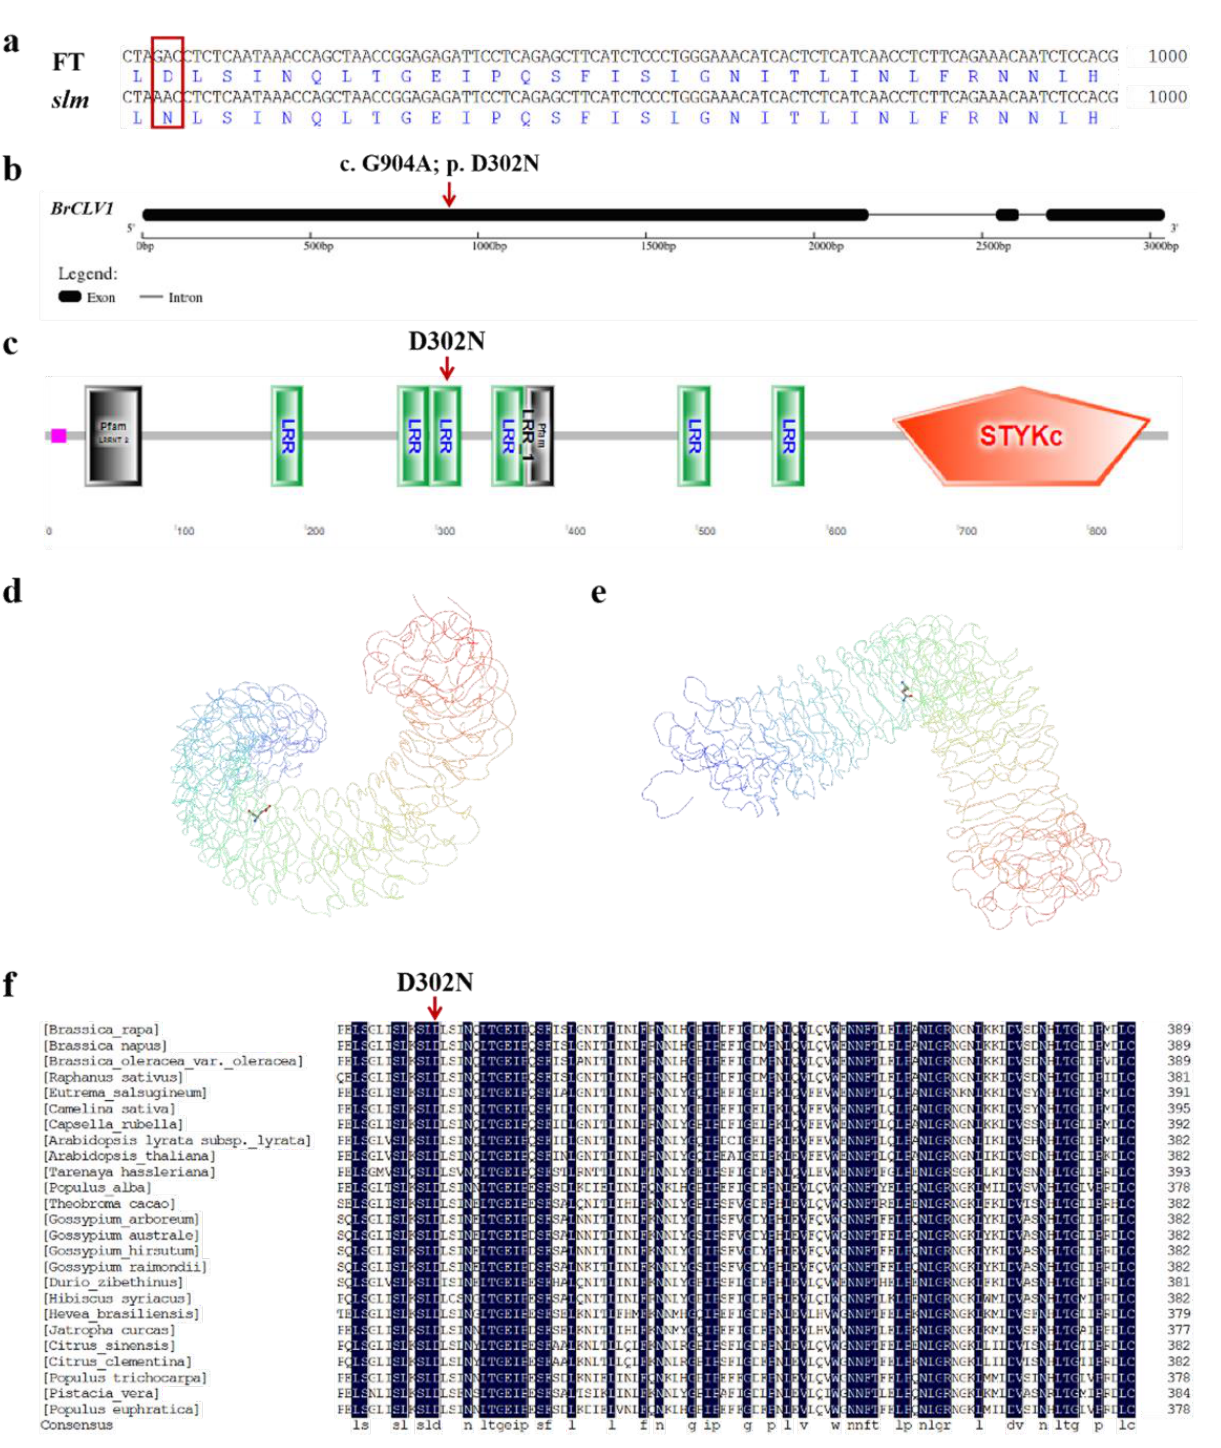
Figure 4. Sequence analysis of BrCLV . ( a ) Alignments of the nucleotide and amino acid sequences of BrCLV1 between FT and slm . The red box indicates the mutation site of slm . ( b ) Gene structure of BrCLV1 and the mutation site of slm . ( c ) Conserved domain of BrCLV1 and the mutation site of slm . ( d ) The three-dimensional structure of BrCLV1. The highlighted amino acid structure represents the 302nd amino acid D of BrCLV1. ( e ) The three-dimensional structure of Brclv1. The highlighted amino acid structure presents the 302nd amino acid N of Brclv1. ( f ) Sequence alignment of CLV1 homologs in 25 species and the mutation site of slm